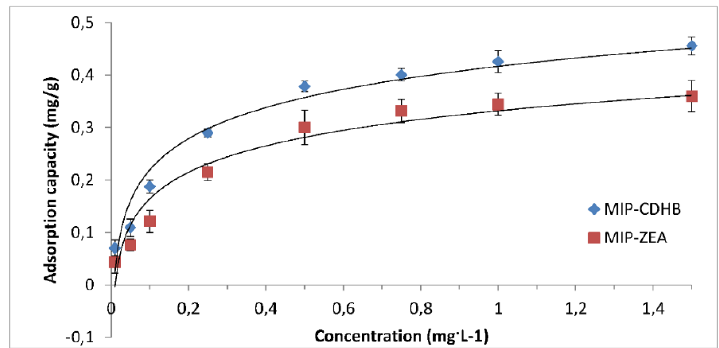
Figure 11. Adsorption capacity of various concentrations of zearalenone by MIP-CDHB and MIP-ZEA.